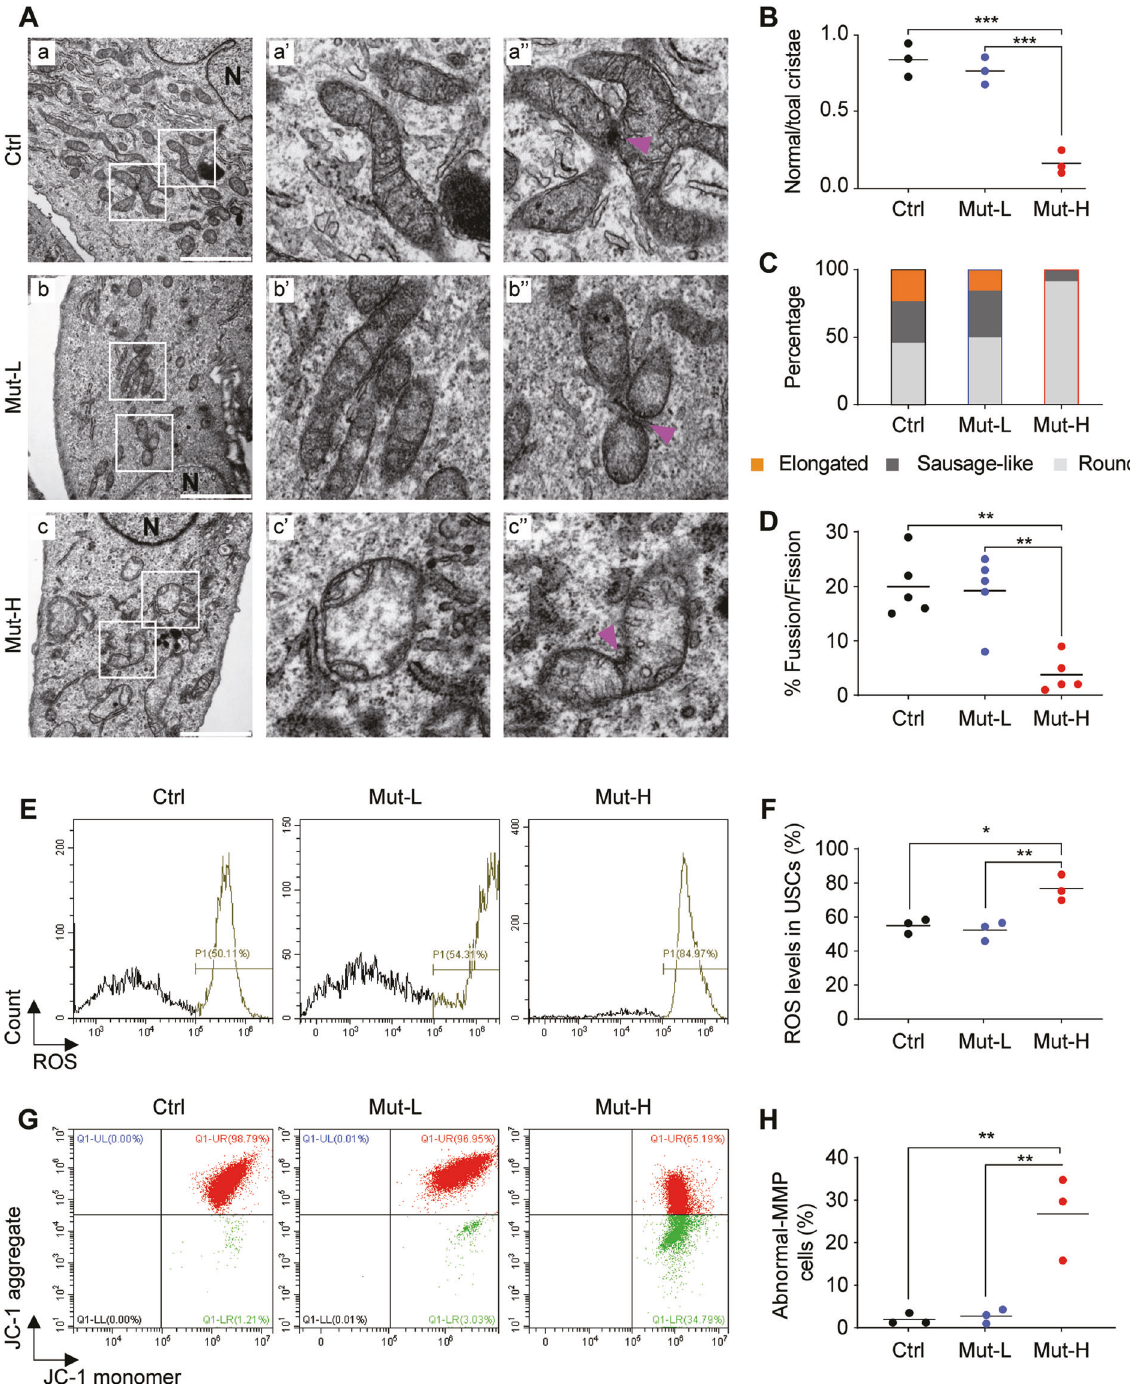
Fig. 2 Impaired mitochondrial morphology and function in m.3243A > G mutant-high USCs. A Mitochondrial morphology as examined by transmission electric microscopy (TEM). Mitochondrial morphology in Ctr USCs (a – a ” : a. Cross-section of Ctr USCs showed round, sausage-like and elongated mitochondria; a ’ . Enlarged mitochondrial with rich cristae; a ” . Mitochondrial junction indicating fi ssion/fusion events (purple arrow)), Mut-L USCs (b – b ” , similar to those in controls), and Mut-H USCs (c – c ” : c. cross-section of Mut-H USCs showed mostly abnormally round, little sausage-like and no elongated mitochondria; c ’ . Enlarged mitochondria lacking normal cristae; and c ” . abnormal mitochondrial junctions). B Quanti fi cation plot showed Mut-H USCs contained high levels of mitochondria with impaired cristae structure. C Quanti fi cation plot showed Mut-H USCs contained less elongated and sausage-like mitochondria. D Quanti fi cation plot showed Mut-H USCs contained less fi ssion/fusion junctions. E Intracellular reactive oxygen species (ROS) generation was measured by fl ow cytometry detecting DCF fl uorescence intensity. F Quanti fi cation plot for E . The ROS level was increased in Mut-H USCs. G The percentage of abnormal-MMP cells was measured by fl ow cytometry detecting the percentage of green fl uorescence of JC-1 dye. H Quanti fi cation plot for G . The mitochondrial membrane potential was decreased in Mut-H USCs USCs. Scale bar: 6 µm. Mitochondria with indicated morphologies were quanti fi ed from TEM images. * P < 0.05, ** P < 0.01, *** P < 0.001.